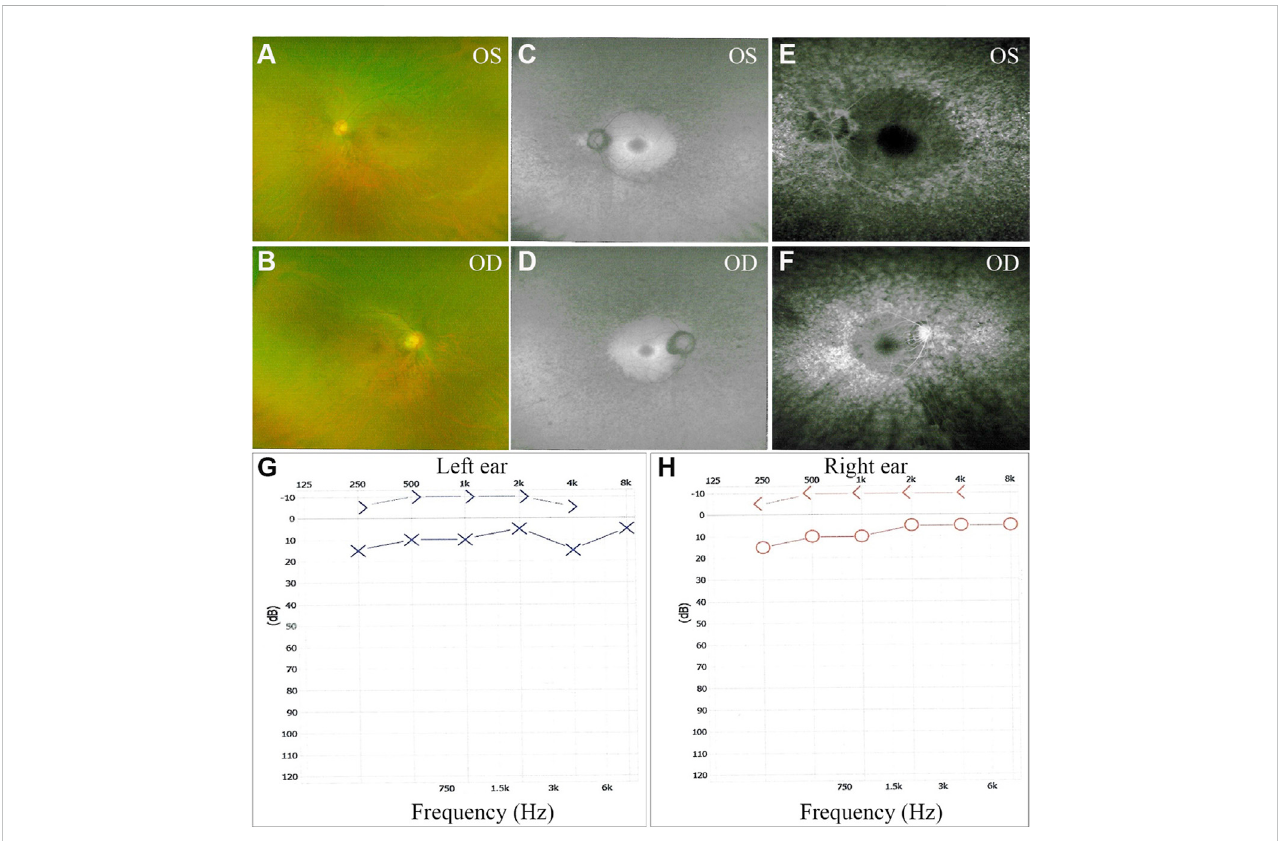
FIGURE 3 Fundus fl uorescein angiography (FFA) and pure-tone audiograms of the proband. (A – F) Bilateral fl uorescein leakage on FFA. (G, H) Audiograms showed no hearing loss in both ears. OS, oculus sinister (left eye); OD, oculus dexter (right eye).